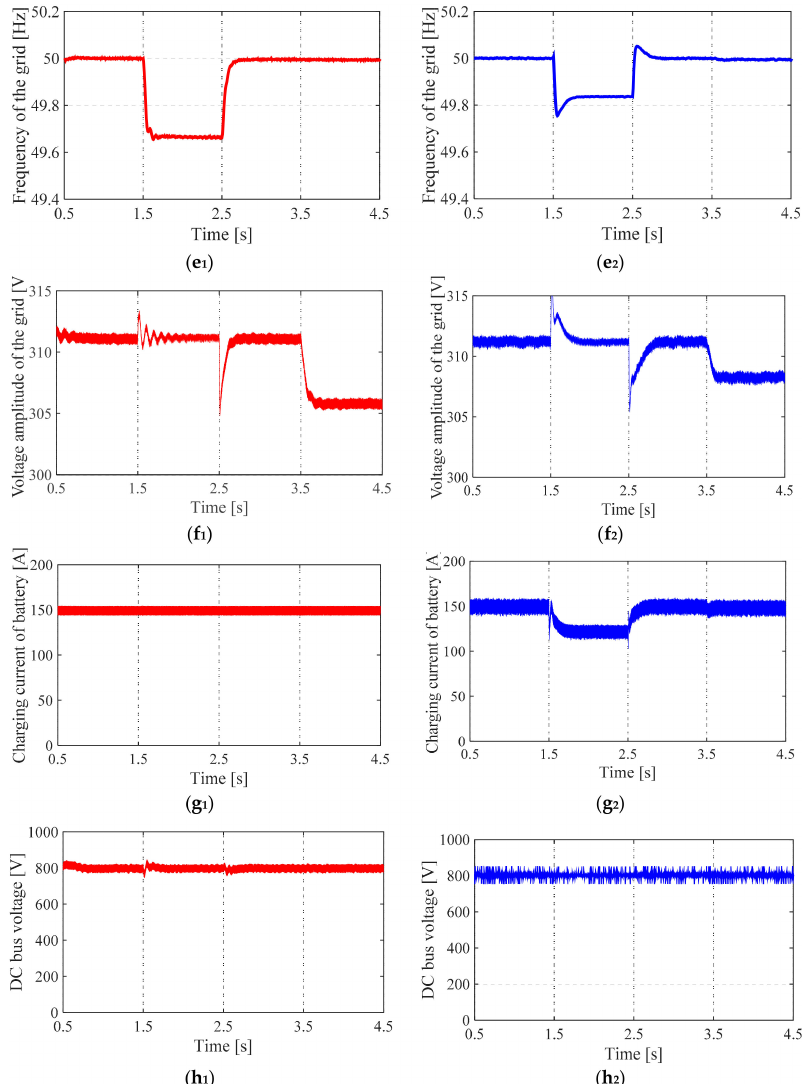
Figure 10. Dynamic response waveforms of the grid and off-board charger I ( a 1 , a 2 ) Active power of the rectifier; ( b 1 , b 2 ) Reactive power of the rectifier; ( c 1 , c 2 ) Active power of the grid; ( d 1 , d 2 ) Reactive power of the grid; ( e 1 , e 2 ) Frequency of the grid; ( f 1 , f 2 ) Voltage amplitude of the grid; ( g 1 , g 2 ) Charging current of the power battery I; ( h 1 , h 2 ) DC bus